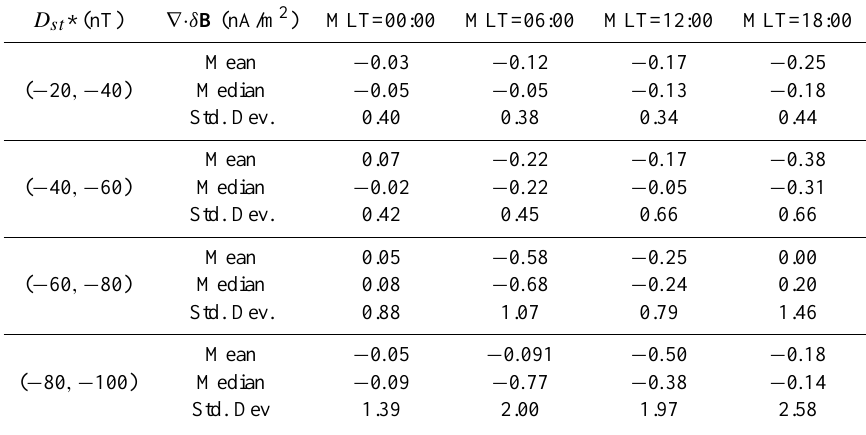
Table 2. Mean, Median and Standard Derivation of ∇· δ B .